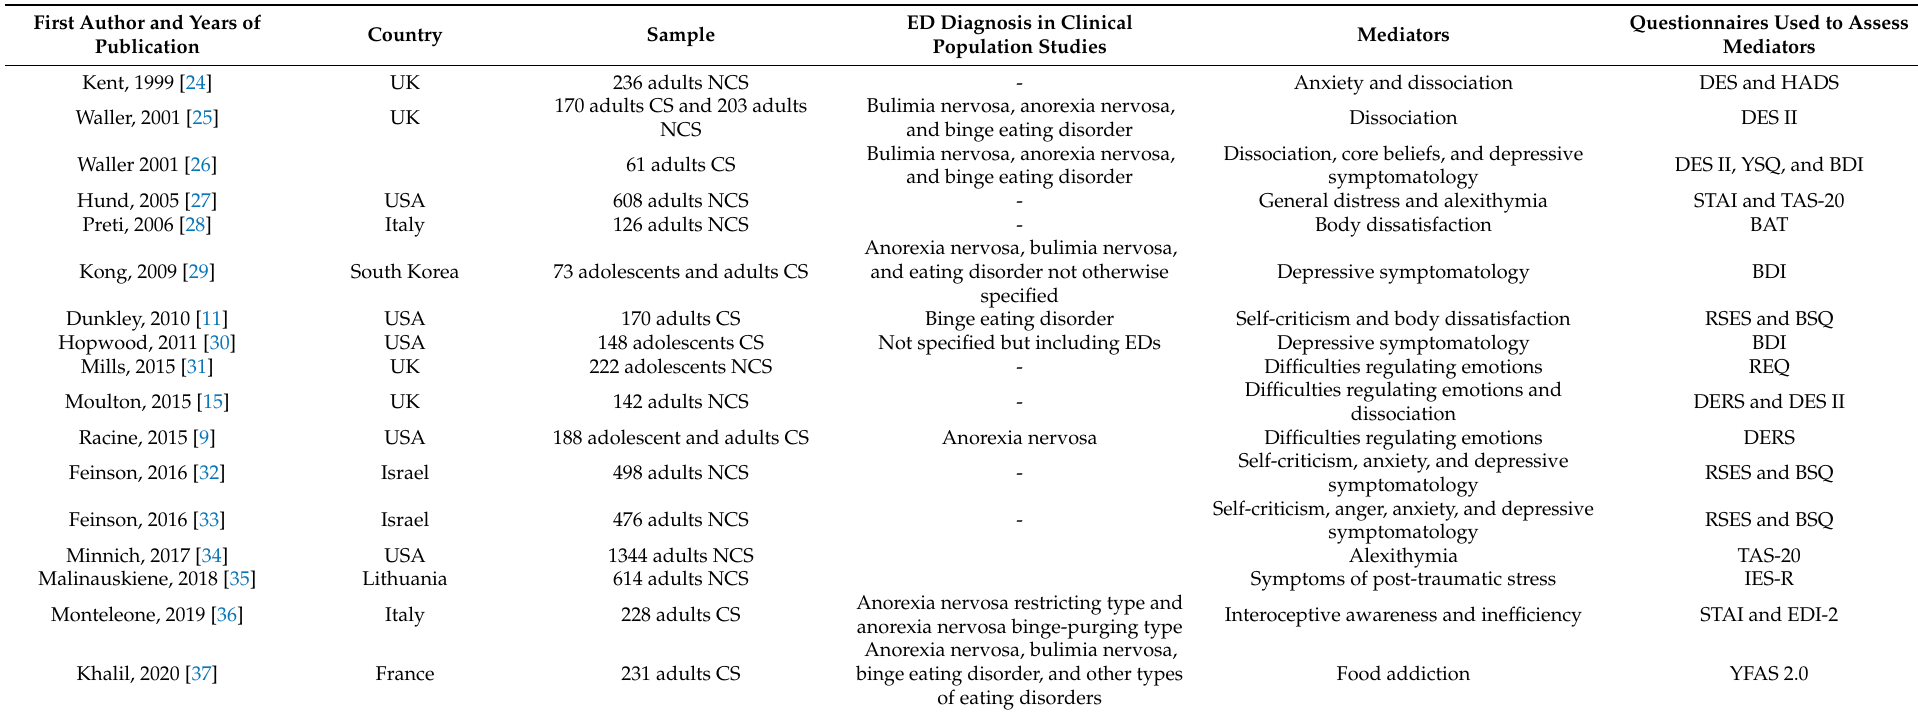
Table 1. List of selected research